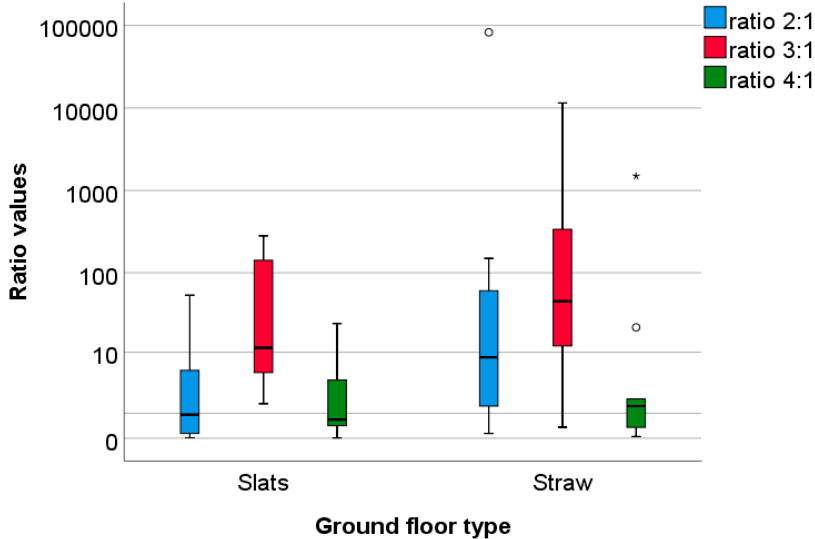
Figure 4. Number of coccidial oocysts/g faeces (OPG) in pens with the ground floor consisting of slatted plastic panels (n = 12) and in pens with the ground floor consisting of concrete littered with straw (n = 12); sampling times: first, second, and fourth week of fattening, as well as the day before first slaughter of the growing rabbits at the beginning of week 7 when aged 82 days.